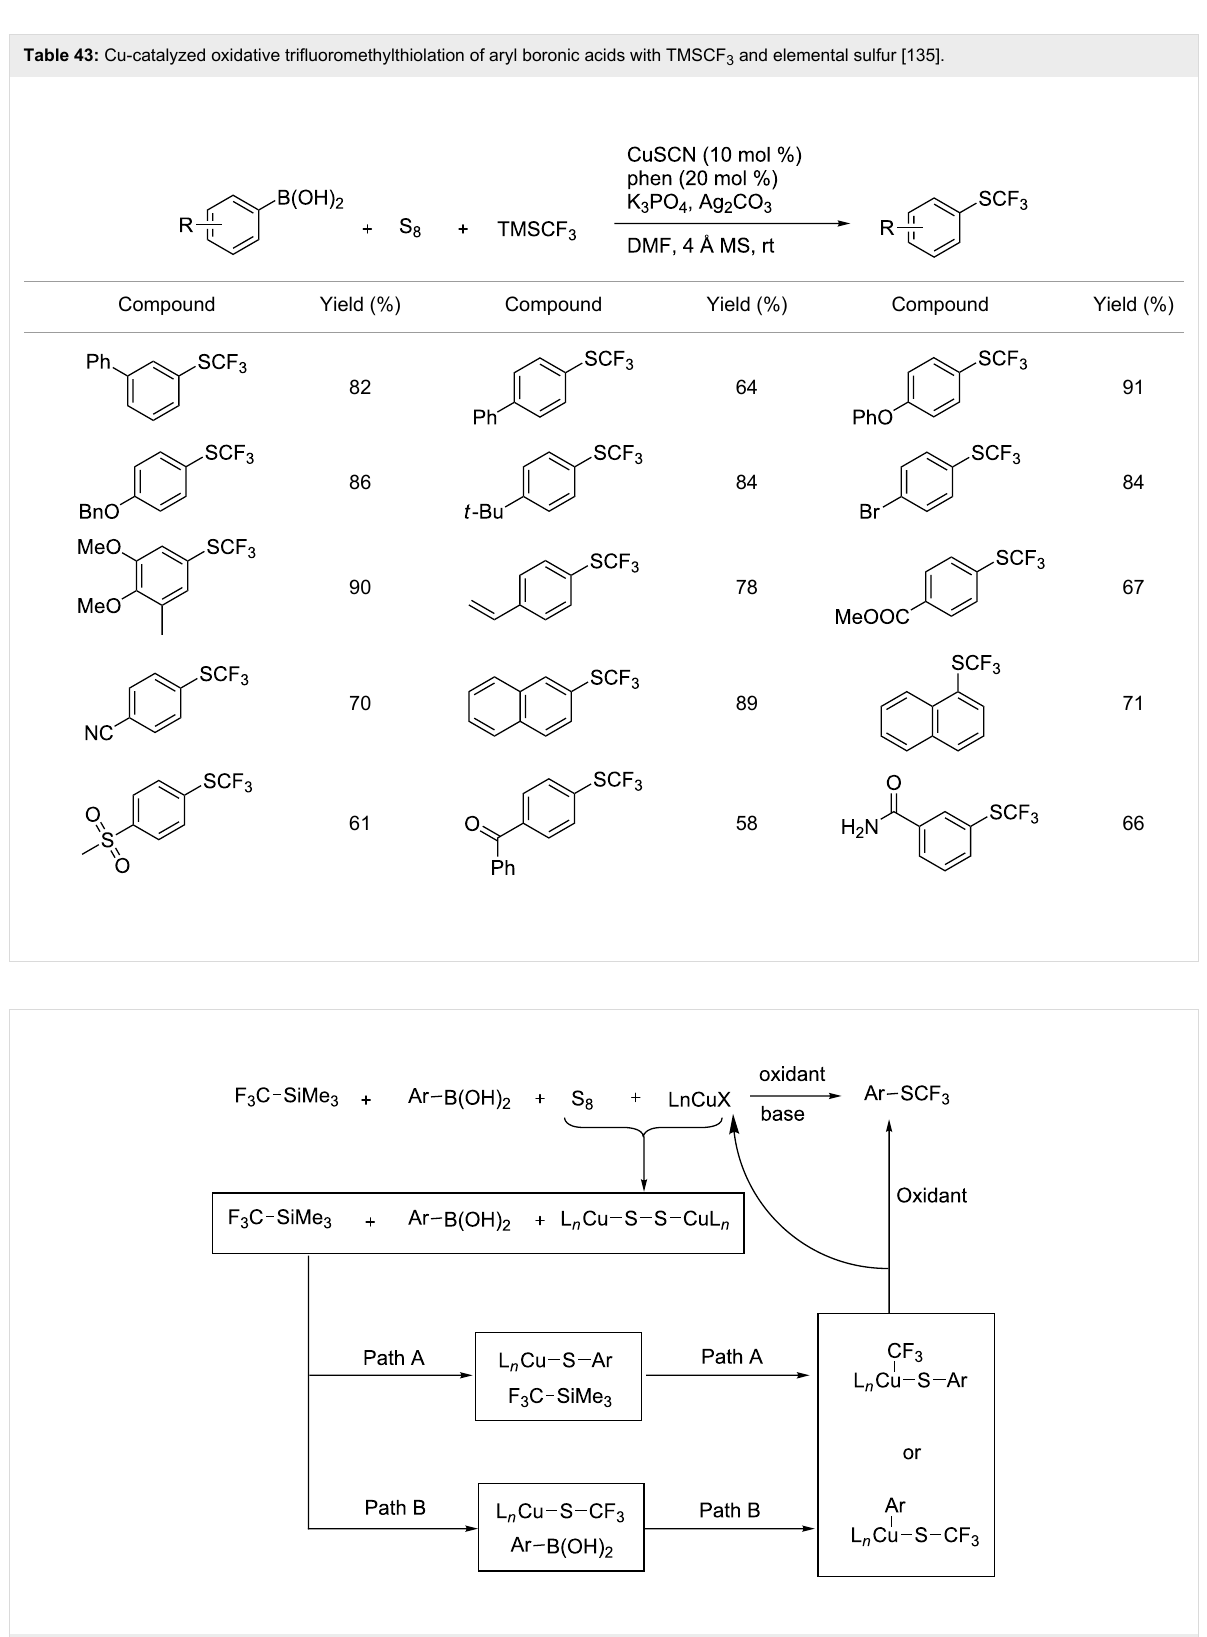
Figure 22: Mechanism of the Cu-catalyzed oxidative trifluoromethylthiolation of arylboronic acids with TMSCF 3 and elemental sulfur